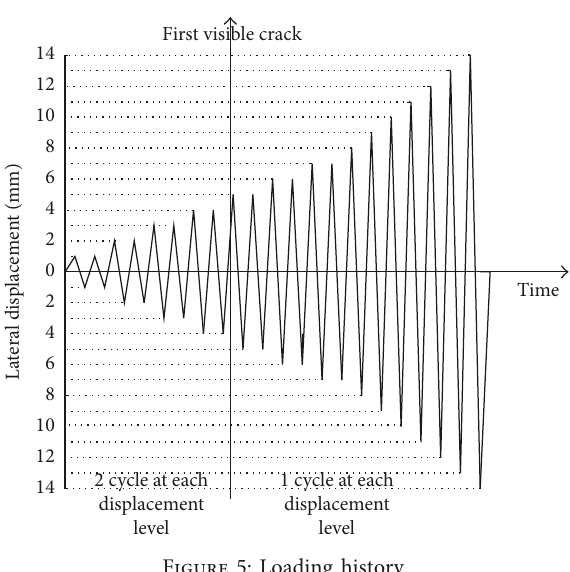
Figure 5: Loading history.